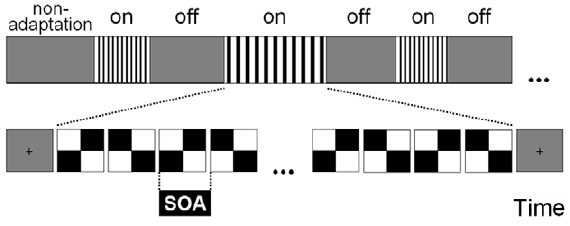
Table 1. Experiment 1.